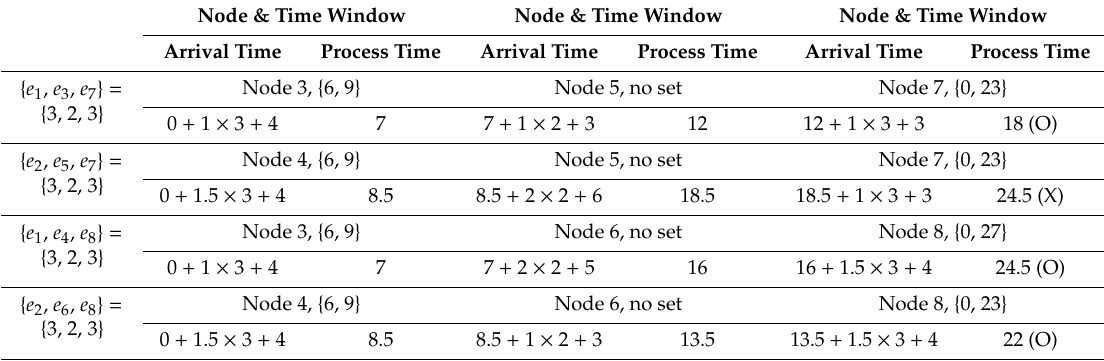
Table 23. Time window inspection process of X 1.